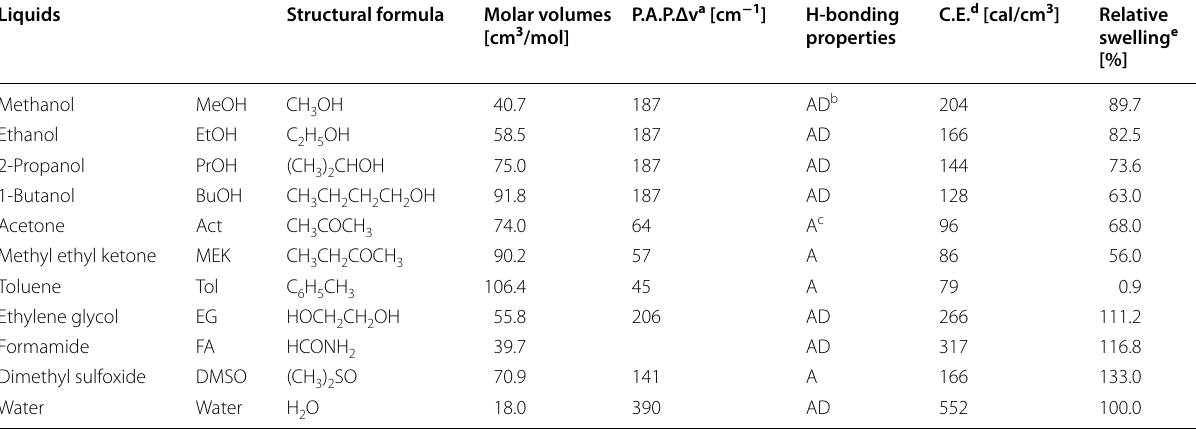
a Proton accepting powers: The data are cited from a table of Kagiya et al. [22], Crowley et al. [23], and Ishimaru et al. [24]. b Liquid having both proton accepting and donating properties for hydrogen bonding. c Liquid having only proton accepting properties for hydrogen bonding. d Cohesion energy: the data are calculated from the solubility parameter values in a table by Hansen [25]. e Relative swelling compared with that in water: The data are cited from a table of Sakai et al. [26] and Ishimaru et al.